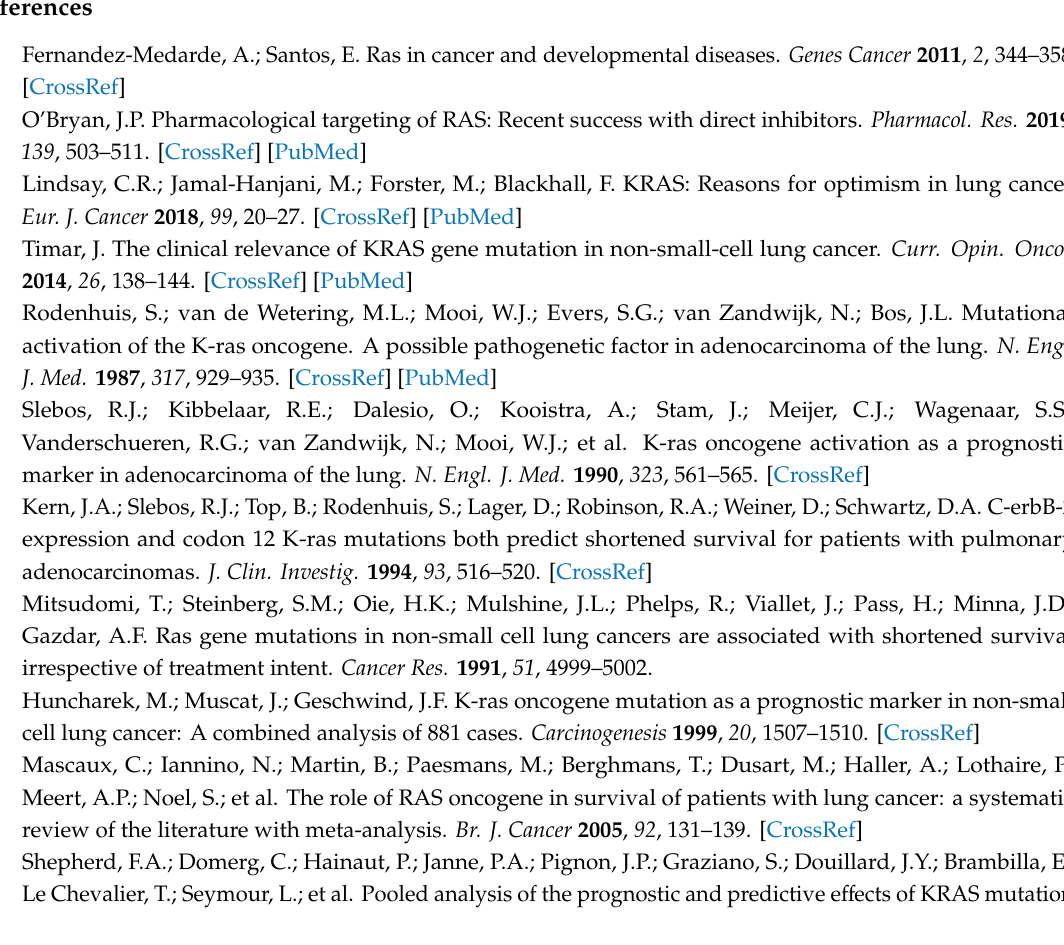
Figure S1. Consort diagram for advanced LADC cases. Consort diagram to demonstrate the selection of stage IIIB / IV LADC cases for BEV / CHT or CHT alone in this study. Where patients were excluded, the reasons for exclusion are indicated. Figure S2. Comparison of survival outcomes in patients with advanced LADC according to treatment regimen. Advanced LADC patients receiving BEV / CHT showed significantly higher median OS compared to those treated with CHT only (median OSs were 24 vs. 10 months, respectively, p < 0.0001, log-rank test). Figure S3. Kaplan-Meier curves for the OS of LADC patients treated with CHTalone and LADC patients with KRAS G12D mutations in the BEV / CHT subcohort. Patients with tumors harboring KRAS G12D mutations and treated with BEV / CHT had comparable OS to that of patients with KRAS-WT or KRAS-mutant tumors in the CHT-alone subcohort. Table S1. Correlation of clinicopathologic features, outcome variables and KRAS codon 12 subtypes in patients with advanced LADC treated with BEV ( n =